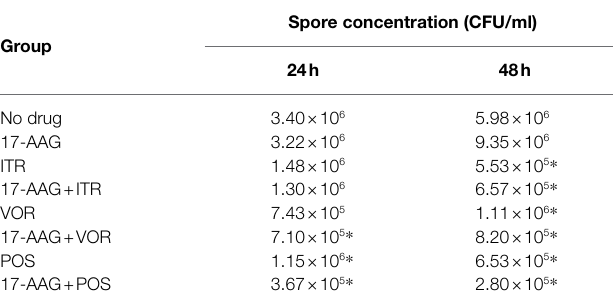
TABLE 3 | Concentration of spores in C. auris AR 382 biofilms.